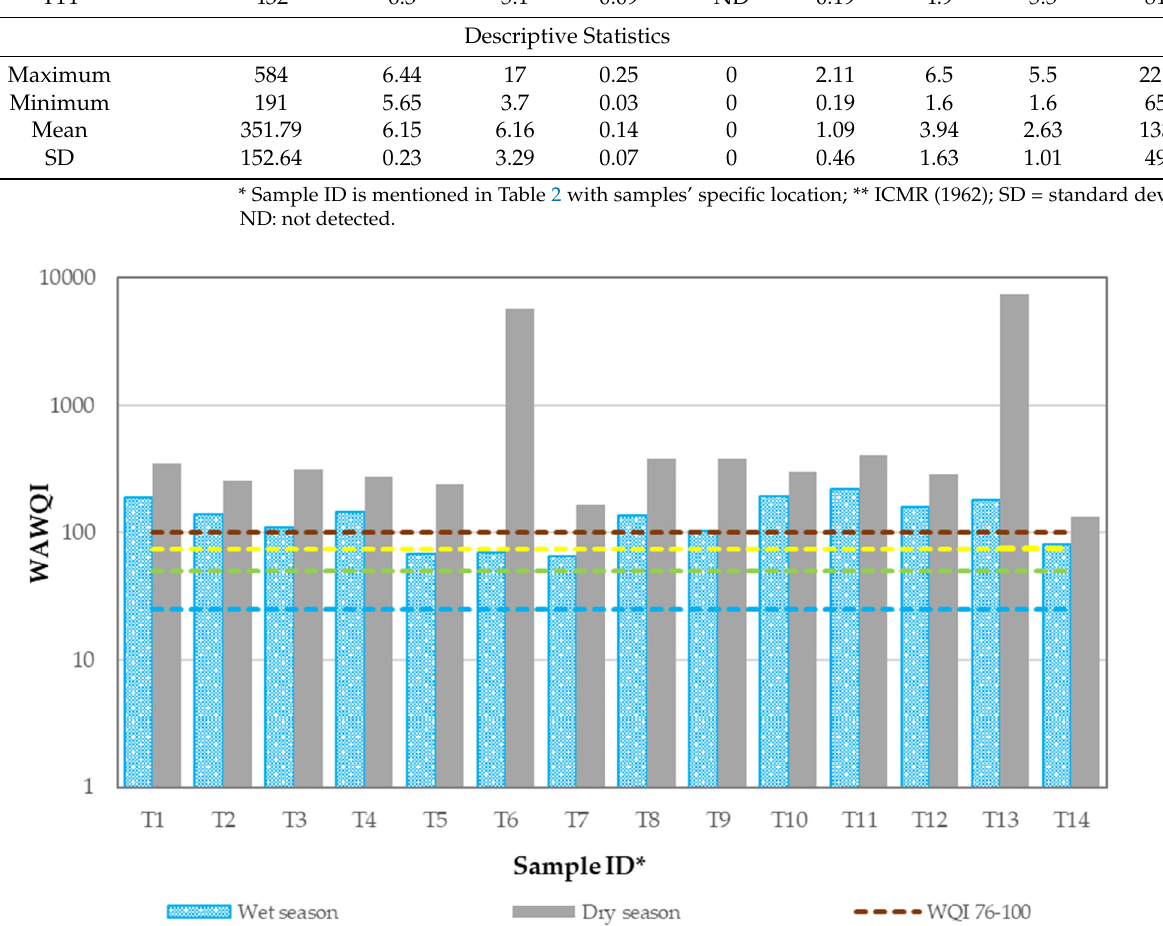
Table 8. Calculation of WAWQI for data at MPMF in Dry season 2018.